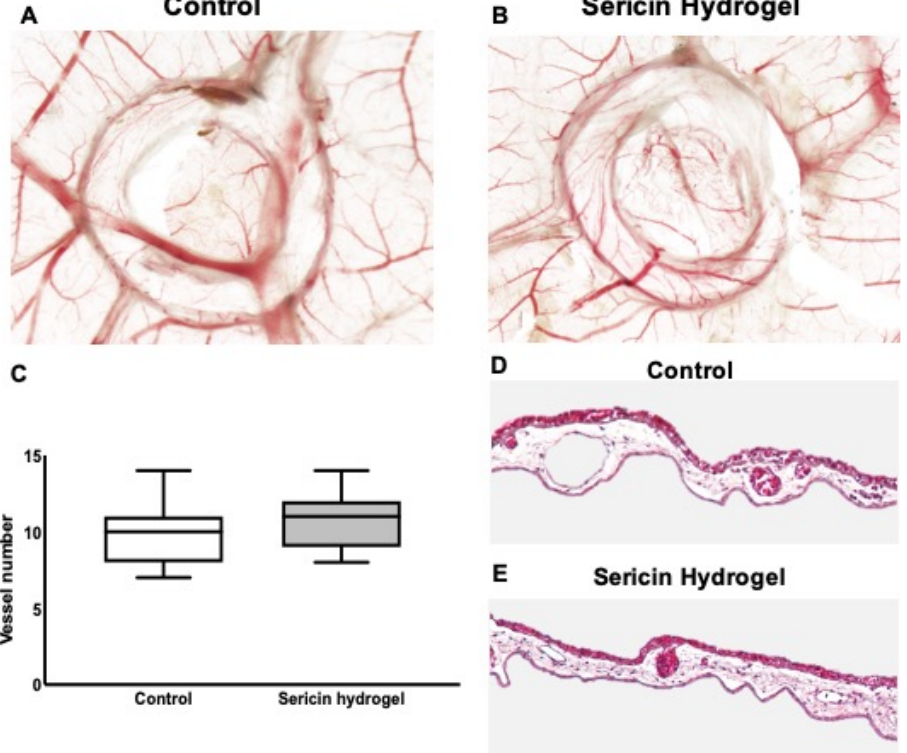
Figure 5. Chick embryo choriollantoic membrane (CAM) assay. ( A , B ) Stereomicroscope images of the excised wounded CAMs that are representative of the two conditions tested pairwise, in the same egg: Saline solution (control) and Sericin Hydrogel (SSH), four days after inoculation; ( C ) Quantification of the newly formed blood vessels (<20 μ m in diameter) at the inoculation site. The data regard 14 eggs (14 pairs of samples) from 3 independent experiments ( D , E ) Representative images of the CAM sections that were stained with H&E, treated with Saline solution (Control), and SSH (20× magnification). The results of 15 pairs from three independent experiments are shown.